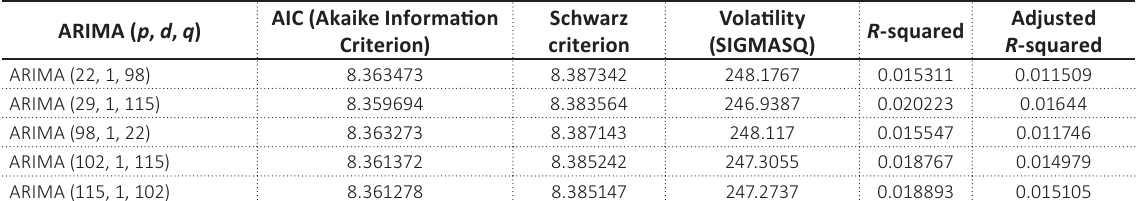
Table 4. Results of the best 5 ARIMA models out of 81 models for Lupin Ltd.